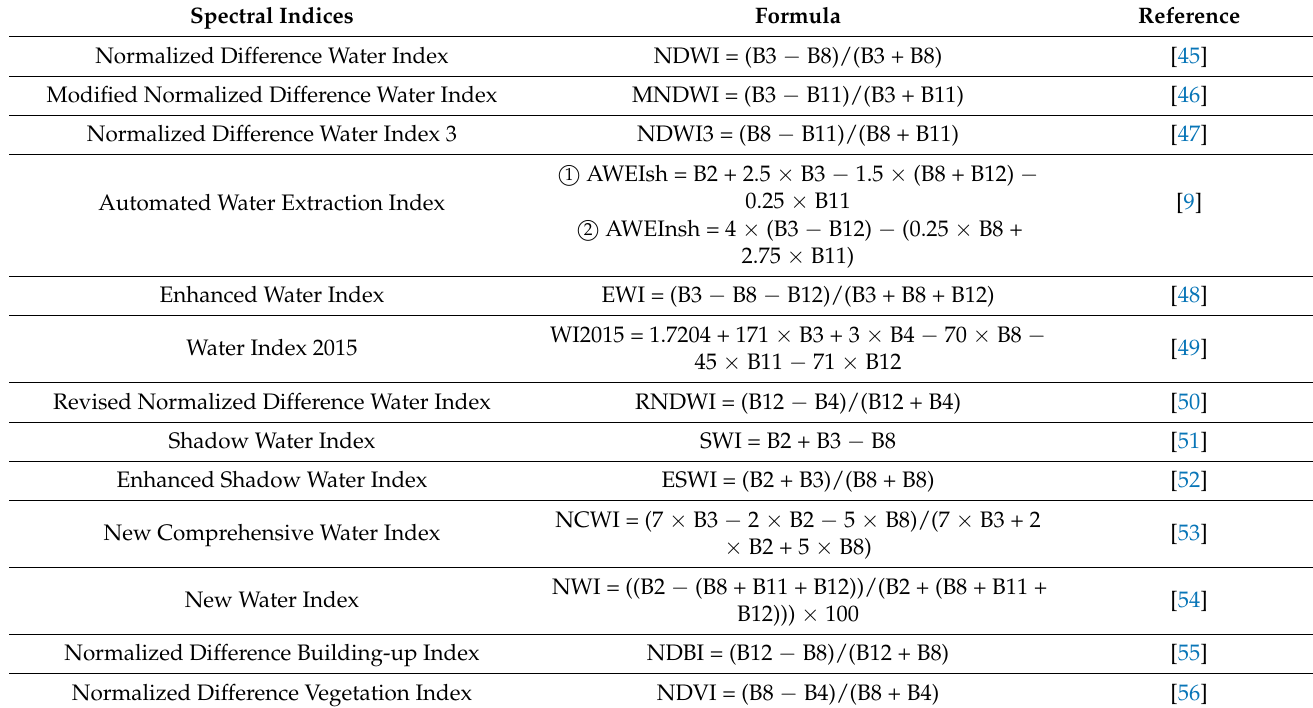
Table 3. Spectral indices of the Sentinel-2